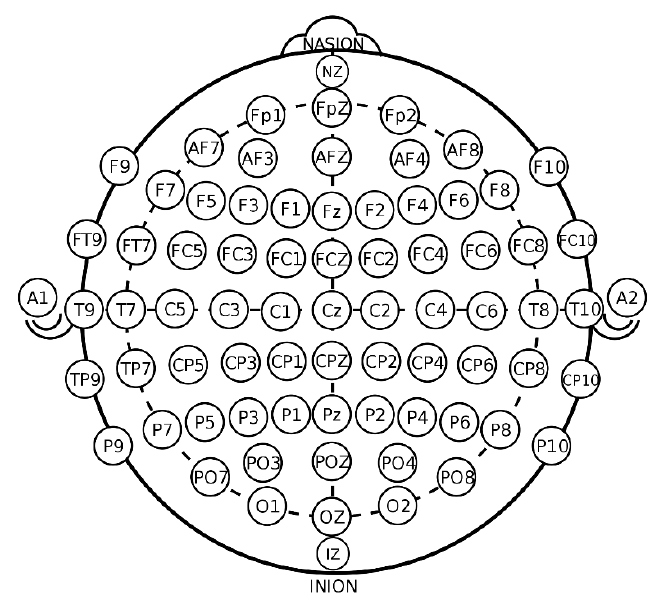
Figure 1. The 10-20 system the international standard and location of the electrodes.